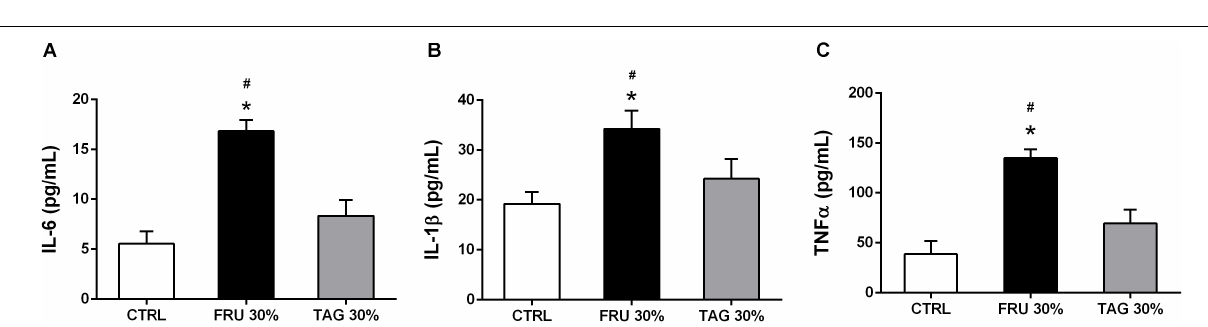
FIGURE 6 | Impact of sugar feeding on systemic concentrations of cytokines. Plasmatic concentrations of interleukin-6 (IL-6) (A) , interleukin-1 β (IL-1 β ) (B), and tumor necrosis factor- α (TNF- α ) (C) were measured in rats fed with CTRL, FRU 30% or TAG 30%. Data are means ± SD for 14 (CTRL and TAG 30%) and 12 (FRU 30%) animals per group; * p < 0.05 vs. CTRL; # p < 0.05 vs. TAG